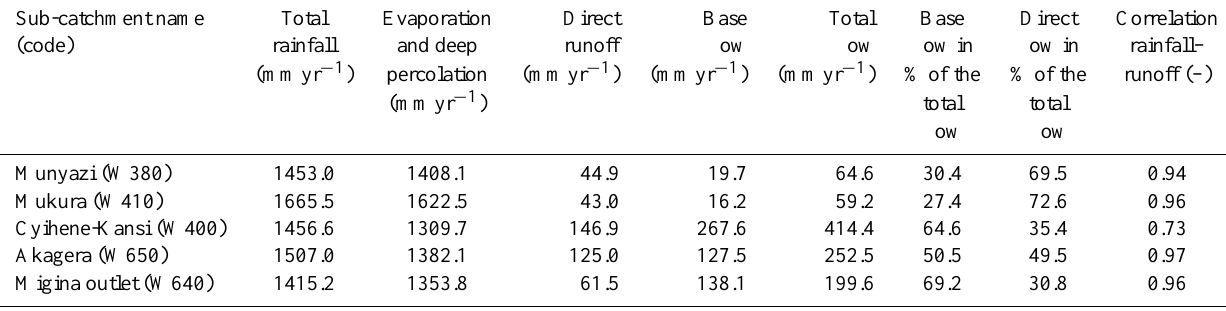
Table 4. Budget component quantities for all sub-catchments in the simulated period of 12 months.